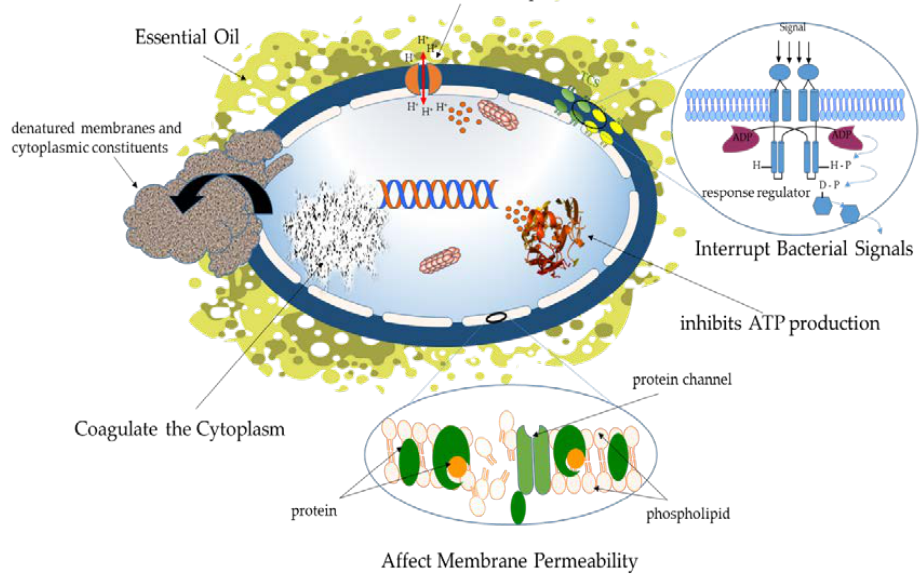
Figure 2. Scheme represents the proposed antibacterial mechanisms of secondary planet metabolizes in their liquid form.